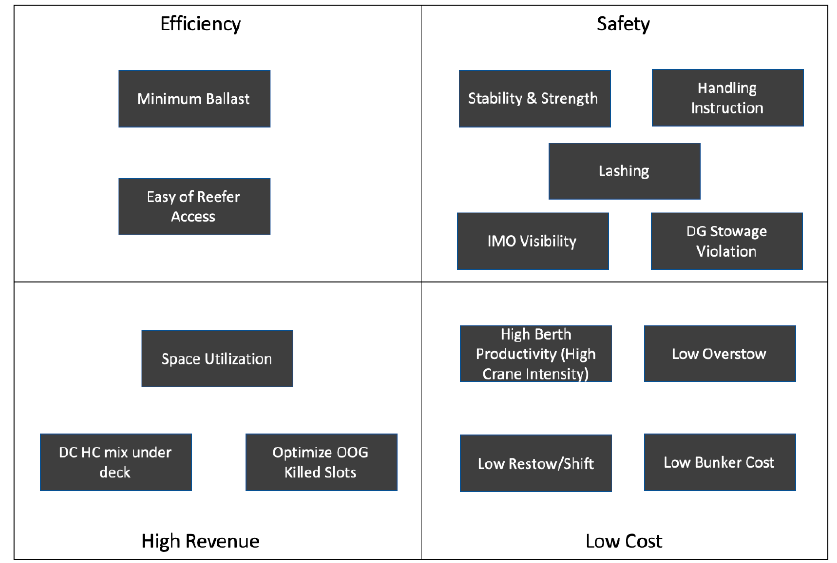
Figure 1. Categorization of stowage planning evaluation.